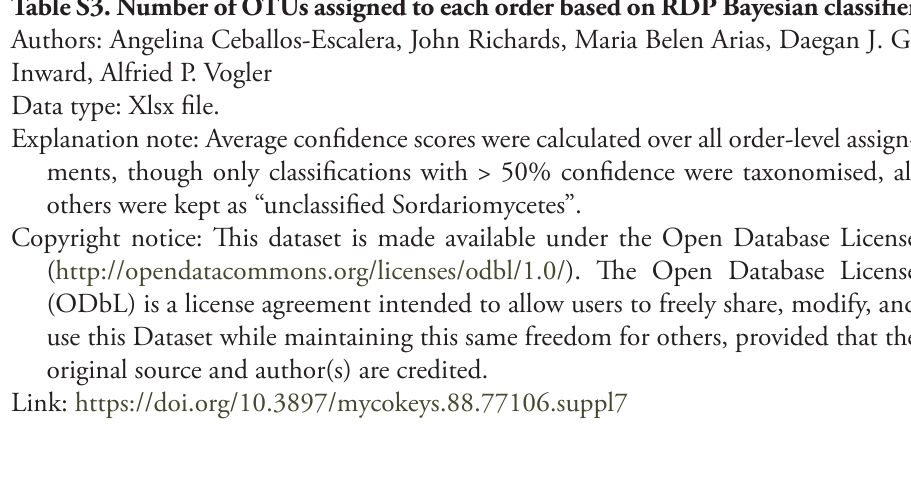
Table S3. Number of OTUs assigned to each order based on RDP Bayesian classifier Authors: Angelina Ceballos-Escalera, John Richards, Maria Belen Arias, Daegan J. G. Inward, Alfried P.